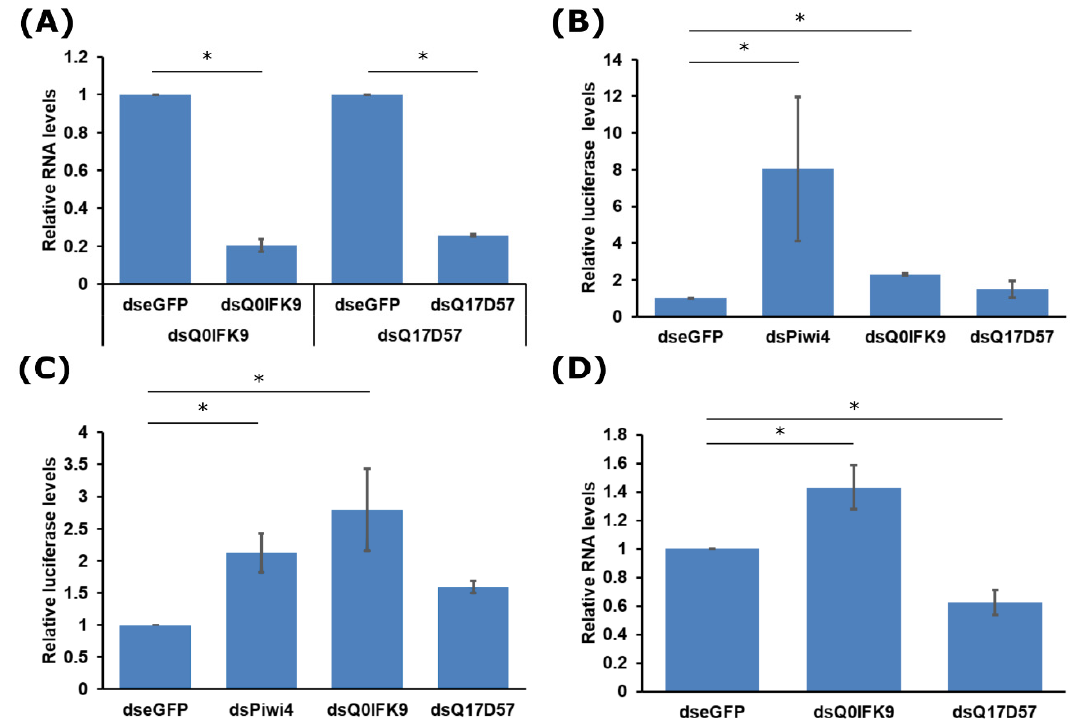
Figure 3. Effect of Q17D57and Q0IFK9 silencing of Semliki Forest (SFV), chikungunya (CHIKV), and Zika virus (ZIKV) replication. ( A ) Aag2 cells were transfected with double-stranded RNAs (dsRNAs) to silence transcripts encoding Q17D57, Q0IFK9, or enhanced green fluorescent protein (eGFP) as control; silencing efficiency was assessed by qRT-PCR on total RNA isolated 24 h p.t., using ΔΔ C method and ribosomal S7 as housekeeping gene. The mean values of three independent experiments with standard error are shown. Transfected cells were infected with SFV(3H)- FFluc ( B ) or CHIKV-2SG- FFLuc ( C ) at multiplicity of infection (MOI) 0.01, 24 h p.t. and lysed at 48 h p.i.; FFLuc activities were determined and presented as relative mean luciferase activity values (normalized to activity in eGFP dsRNA treated control); the error of the mean from three independent experiments conducted in triplicate are shown. ( D ) Cells transfected as described above were infected with ZIKV PE243 at MOI 0.1 and total RNA isolated at 72 h p.i. to quantify viral RNA levels (S7 used as housekeeping gene). The mean values of four independent experiments with standard error are shown. For statistical analysis, values in (B) and (C) were log-transformed to reduce the heterogeneity; * indicates significance, p < 0.05 (Student’s two-tailed t -test).